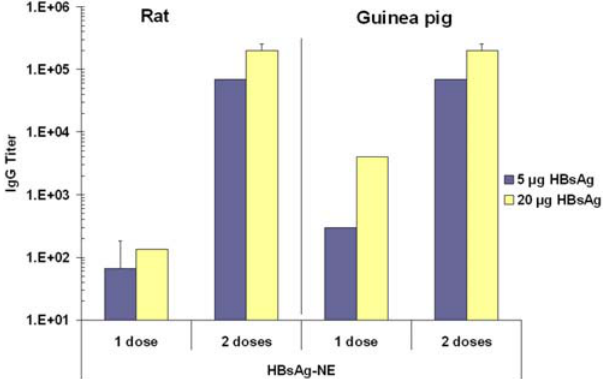
Figure 6. Immunogenicity in rats and guinea pigs. Rats and guinea pigs were immunized intranasally with either 5 m g or 20 m g HBsAg mixed with 20% NE. Serum anti-HBsAg IgG antibody concen- trations are presented as mean of endpoint titers in individual sera 6 SEM. Data represents anti-HBsAg end titers measured 3 weeks after a single dose (1 dose) vaccination and after two vaccinations (2 doses) measured at 7 weeks.